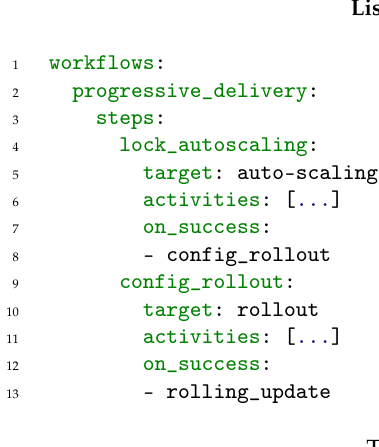
Listing 7. Orchestration workflow of progressive delivery.